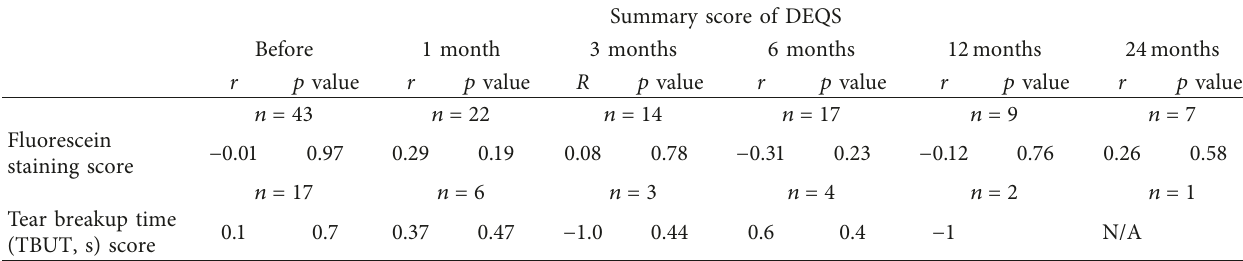
Table 4: The correlations between the DEQS and the clinical findings. Summary score of